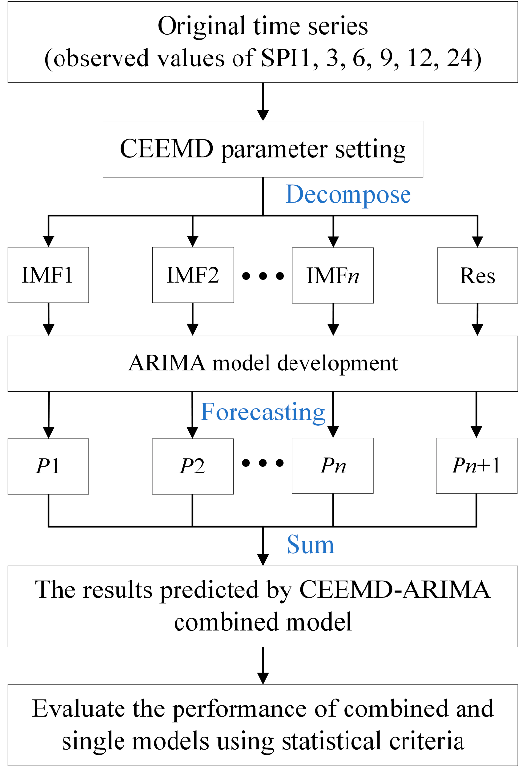
Figure 2. Workflow of the CEEMD–ARIMA combined model.